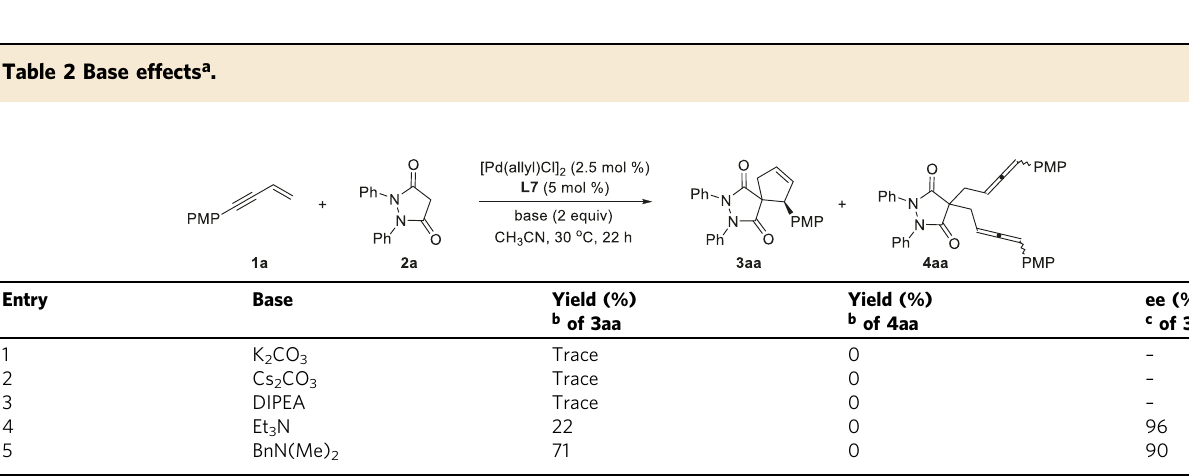
Table 2 Base effects a